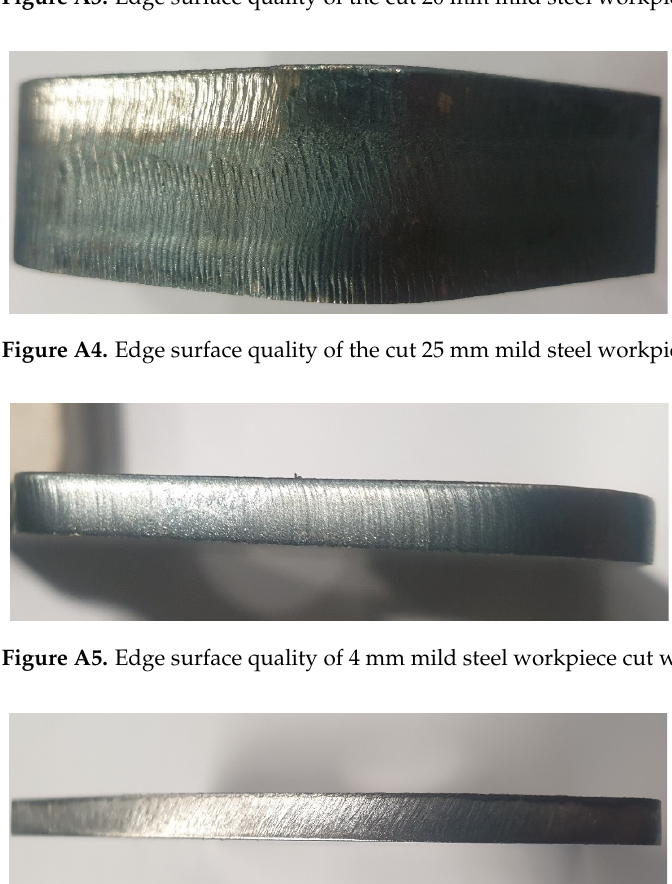
Figure A6. Edge surface quality of 3 mm mild steel workpiece cut with Nitrogen.